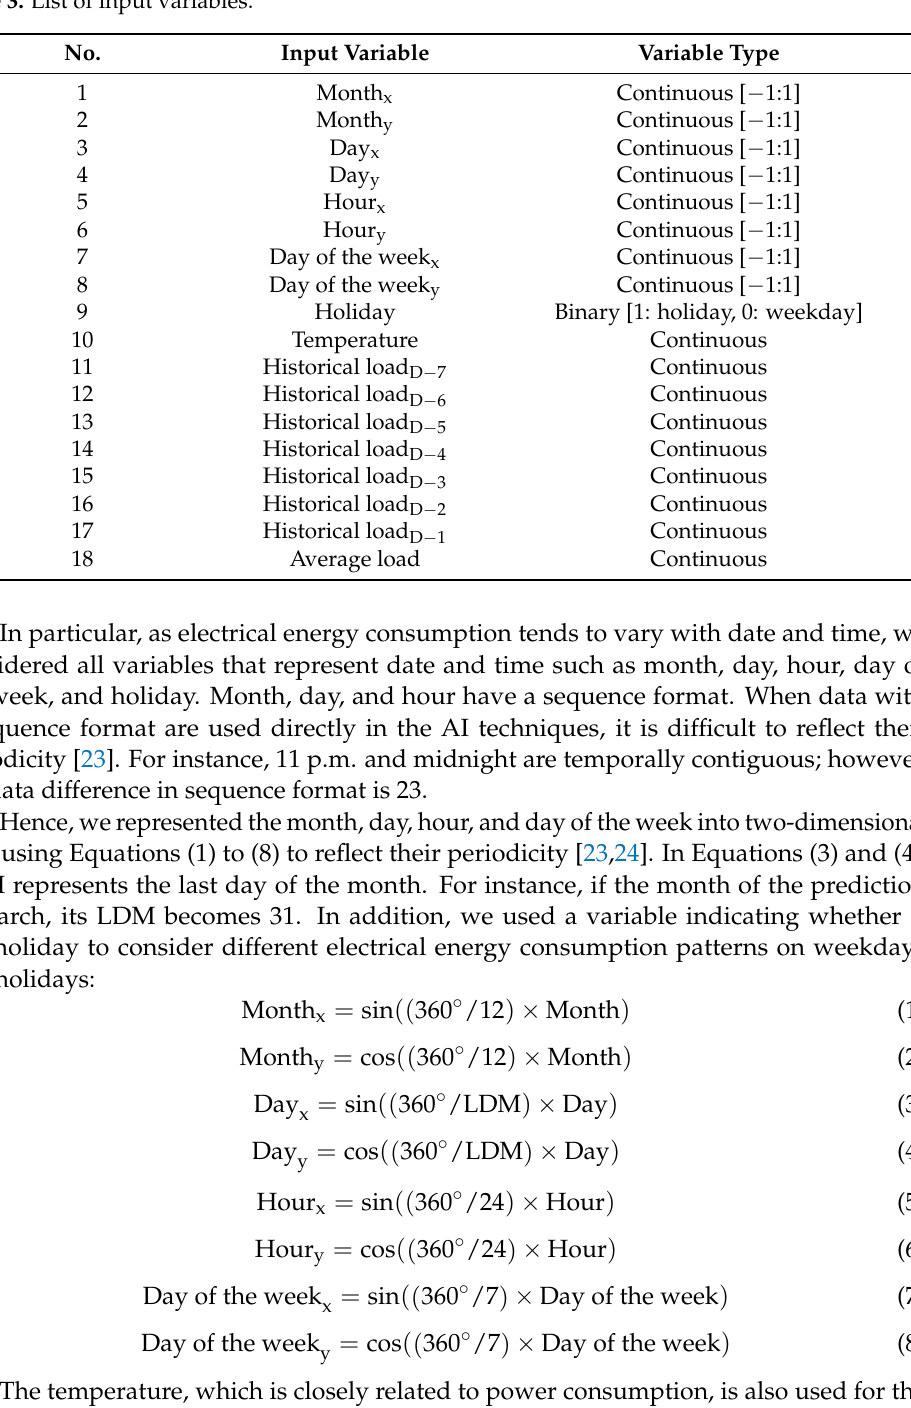
Table 3. List of input